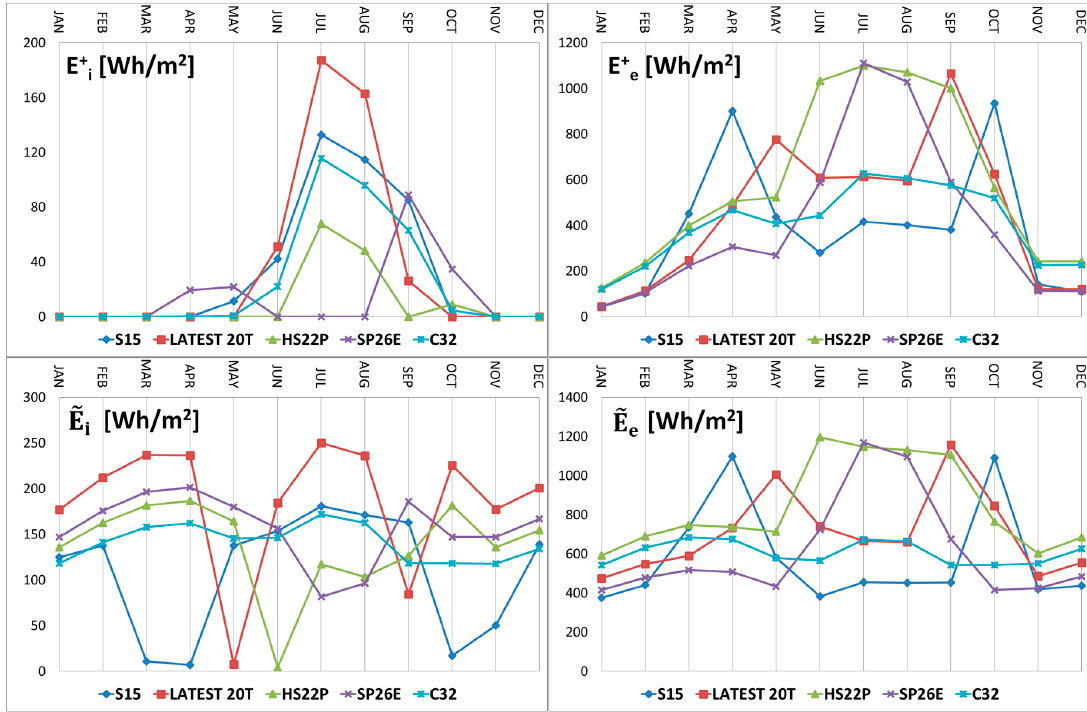
Figure 5. Monthly average daily values of the total energy and of the fluctuating component transferred through the external surface, (cid:1831) (cid:3032)(cid:2878) , (cid:1831) (cid:3032)(cid:2879) and (cid:1831)(cid:3560) (cid:3032) , and through the internal surface, (cid:1831) (cid:3036)(cid:2878) , (cid:1831) (cid:3036)(cid:2879) and (cid:1831)(cid:3560) (cid:3036) , for the different PCMs, Turin.